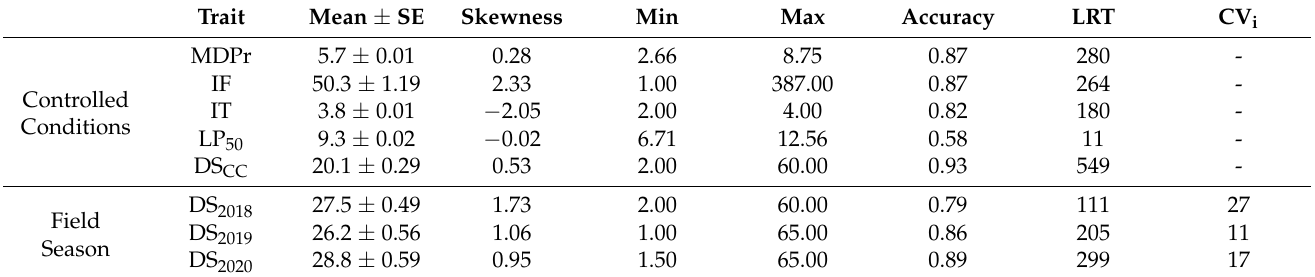
Table 2. Statistics performed for disease components studied in CC and under field conditions. Arithmetic mean ± standard error (SE), minimum and maximum values, skewness, accuracy of the selection in LMM applied, and their likelihood ratio test for genotype effect (LRT). The percentage of genotype-by-environment interaction coefficient of variation (CV i ) is also shown with a significance p < 0.01.